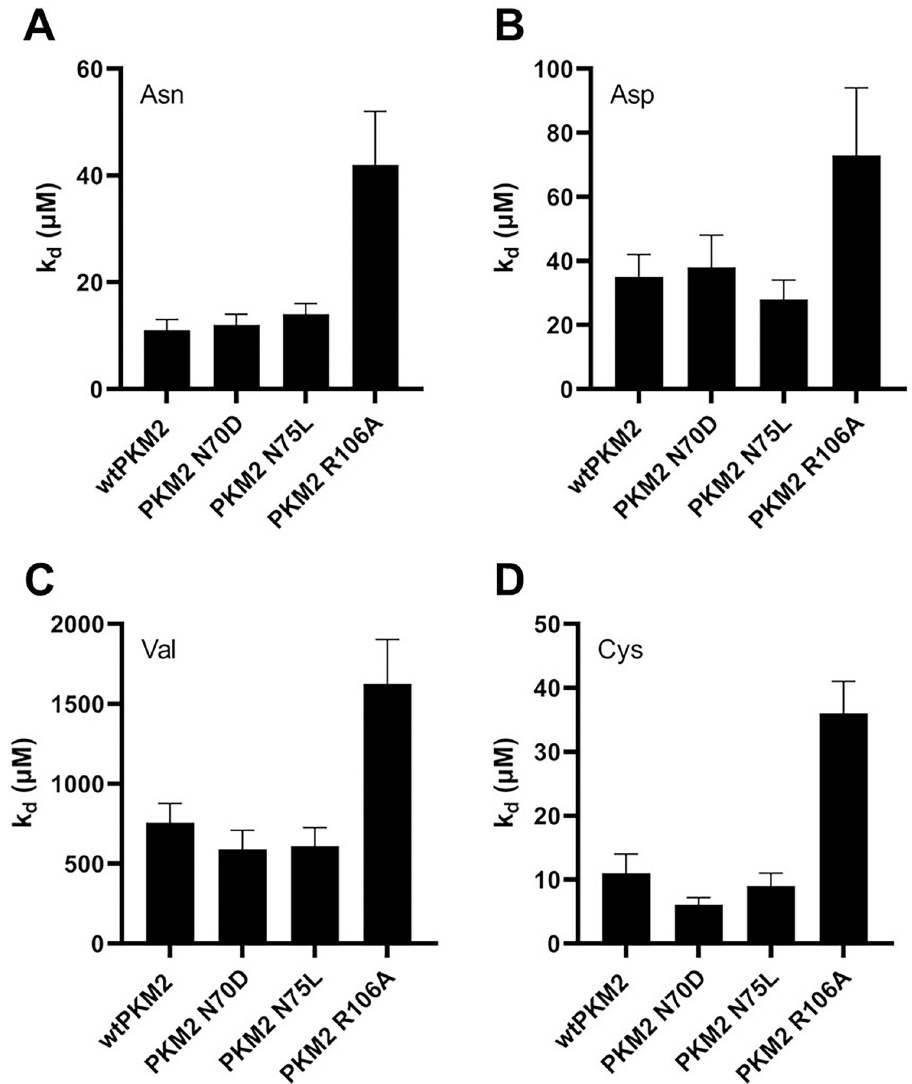
Fig 3. Binding affinities of PKM2 N70D, PKM2 N75L, PKM2 R106A, and wtPKM2 for: (A) Asn, (B) Asp, (C) Val, and (D) Cys. The data demonstrate that the R106A variant has a much weaker binding affinity for all AAs. The concentrations of each enzyme were kept constant at 1.6 μ M. The dissociation constant ( K Table.